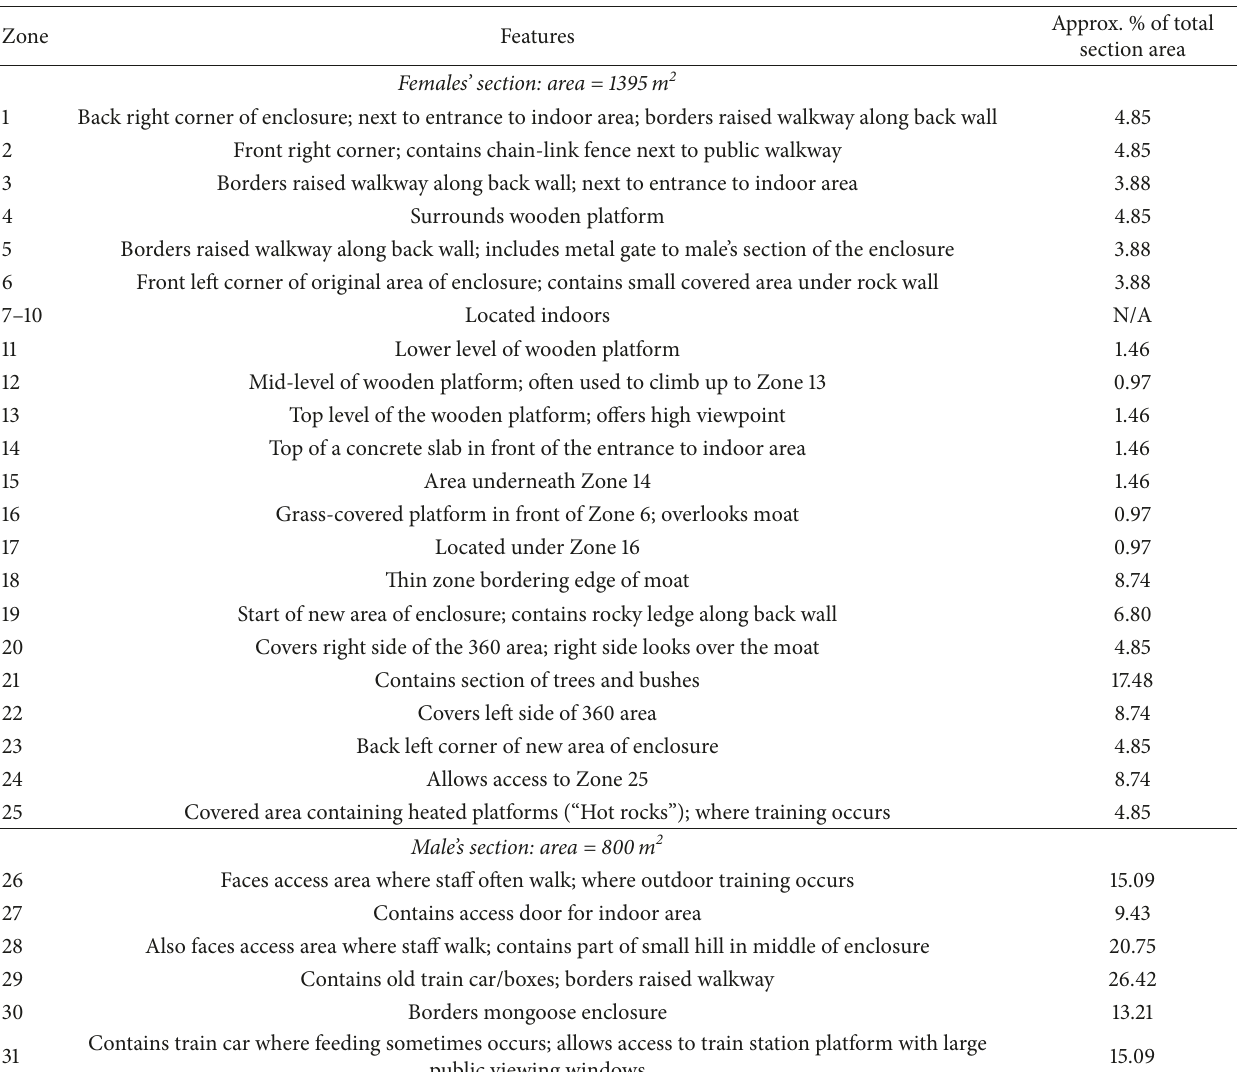
Table 11: Zone descriptions of London